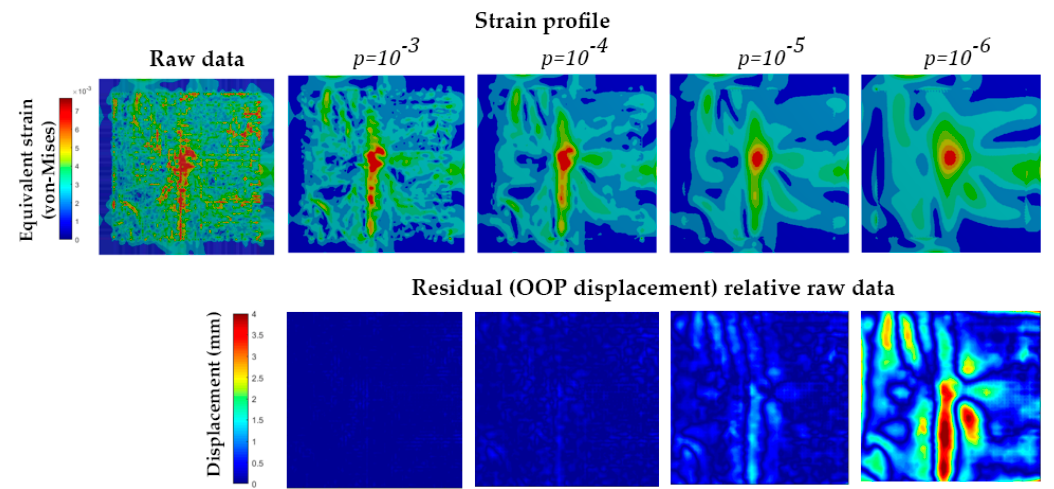
Figure 6. OOP deformation test: Equivalent strain (von-Mises) of raw data and different cubic smoothing spline parameters and its residual out-of-plane displacement relative to raw data (no filter).